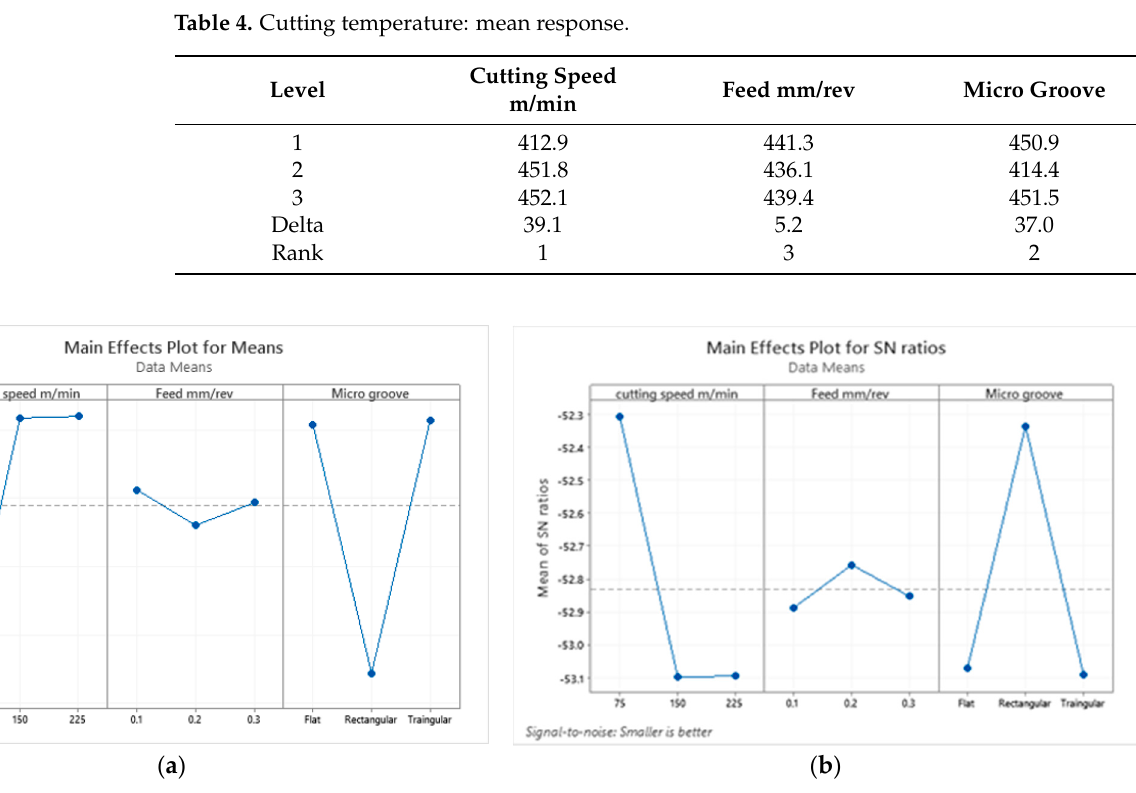
Figure 6. ( a ) Mean and ( b ) signal to noise plots for temperature values. Table 5. Analysis of variance for temperature